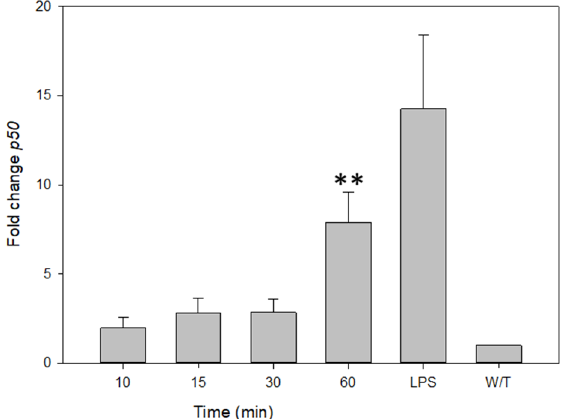
Figure 6. The VCC initiates the expression of the transcription factor NF- κ B. THP-1 cells were treated with the VCC toxin at 10, 15, 30 and 60 min. LPS (1 μ g/mL) was used as a positive control. The VCC starts the transcriptional regulation of subunits of NF ‐κ B, p50. The mRNA expressions were evaluated using qp ‐ PCR. Changes in expression were compared with the control without treatment and normalized with the housekeeping gene NAPDH. The graphic includes results from three performed experiments. W/T, without treatment. Mean ± SD. ** p < 0.05, significantly different from that without treatment (ANOVA plus the Student–Newman–Keuls method).